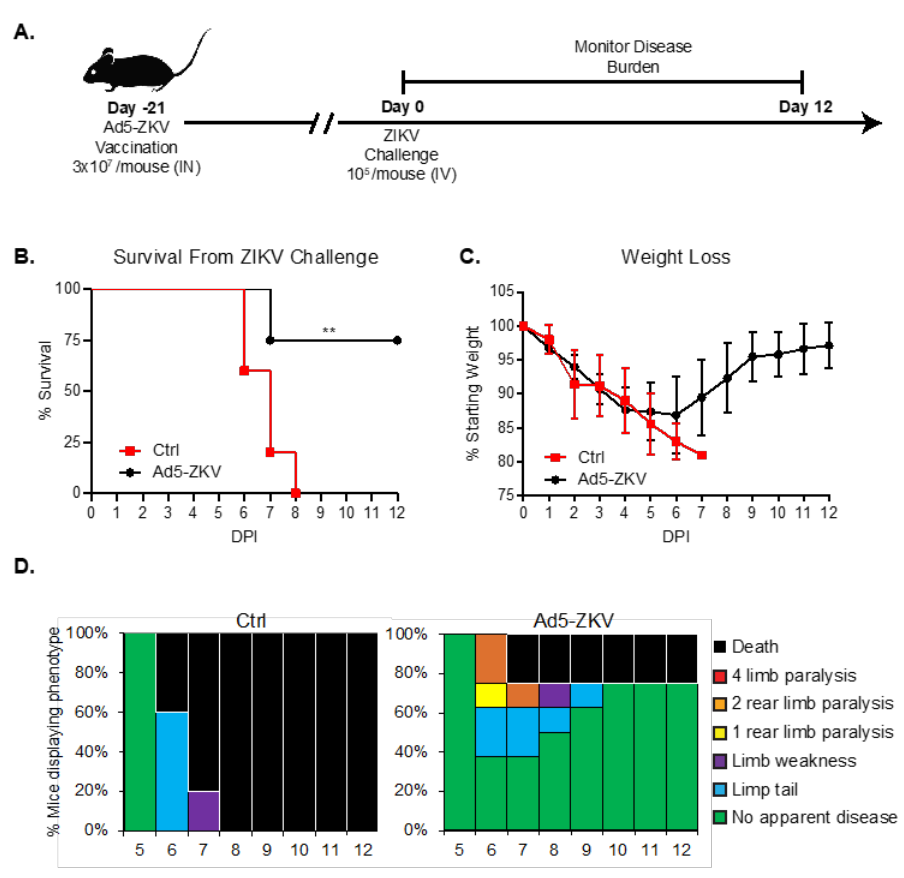
Figure 4. Protective Capacity of hAd5-ZKV vaccine vector encoding CD8 + T cell and B cell epitopes. ( A ) Graphical timeline for hAd5-ZKV vaccination. 3 × 10 7 viral particles of hAd5-ZKV were administered intranasally to Ifnar1 - / - mice. Twenty-one days later, both the vaccinated animals and a PBS-vaccinated control group were sub-lethally challenged with 1 × 10 4 FFU i.v. of ZIKV PRVABC59, and weight loss was monitored. ( B ) ZIKV disease-associated clinical scores were monitored over the twelve-day period post challenge with n = 8 for vaccination and n = 5 for control. Statistical significance for survival (** p = 0.002) was determined using a log-rank (Mantel–Cox) test. ( C ) ZIKV-induced weight loss was monitored over the twelve-day period post challenge. Data are the cumulative results of two independent experiments. ( D ) Clinical disease score over the twelve-day period post challenge with ZIKV. Phenotypes evaluated included limp tail, limb weakness, limb paralysis, and death. Data are the cumulative results of two independent